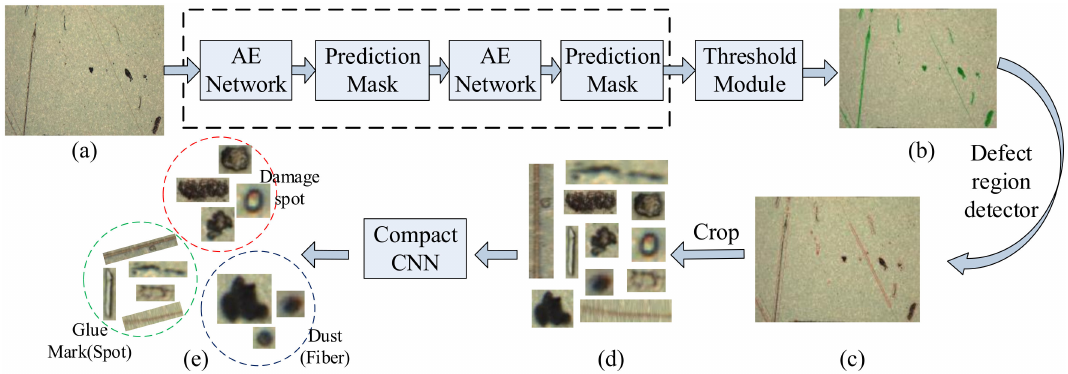
Figure 2. The pipeline of the proposed metallic surface defect inspection architecture. ( a ) Original image, ( b ) defect segment, ( c ) defect location, ( d ) cropped results, and ( e )